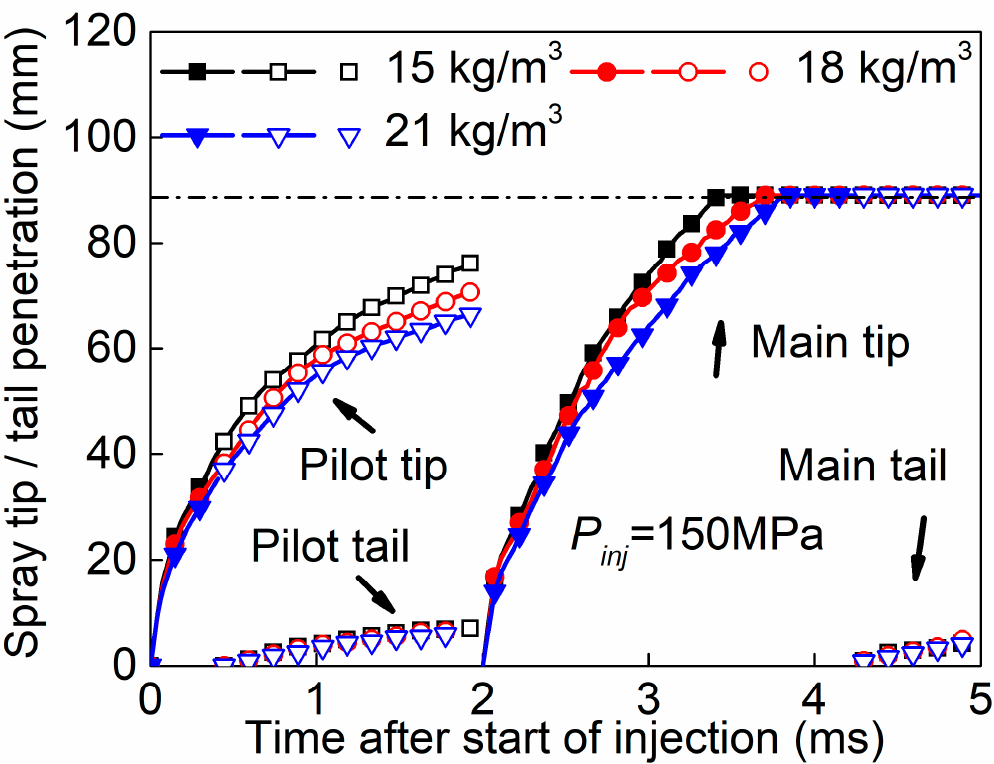
Figure 13. Results of tip and tail penetrations when applying the pilot-main injection strategy under various surrounding gas densities.